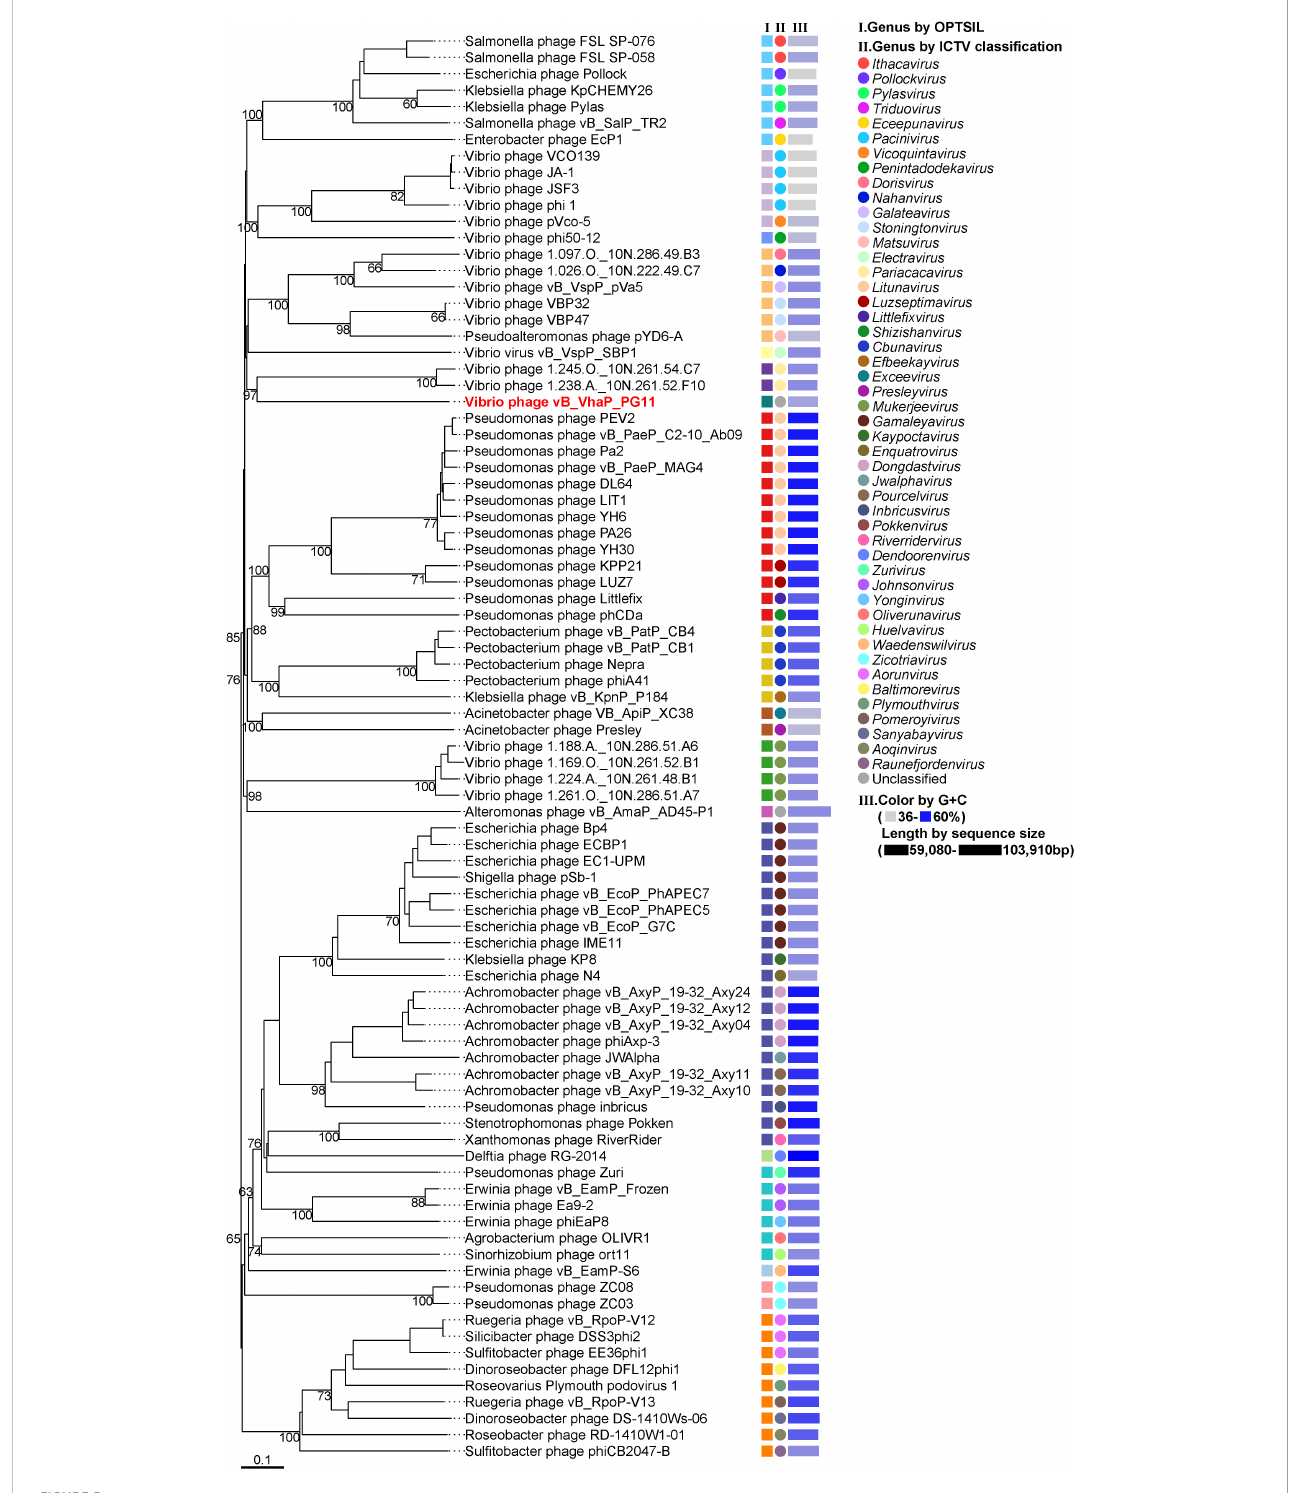
FIGURE 5 Whole-genome based proteomic tree of Vibrio phage vB_VhaP_PG11 and RefSeq of Schitoviridae from NCBI database and constructed by Virus Classi fi cation and Tree Building Online Resource (VICTOR) with the formula d6. The proteomic tree consists of 87 phage genomes. Three series of color boxes behind the tree indicate: I. Genera classi fi ed of all these phages classi fi ed by OPTSIL; II. Genera classi fi ed by ICTV; III. GC content and sequence size. GC content is represented by the color of the block, and the sequence size is represented by the length of the